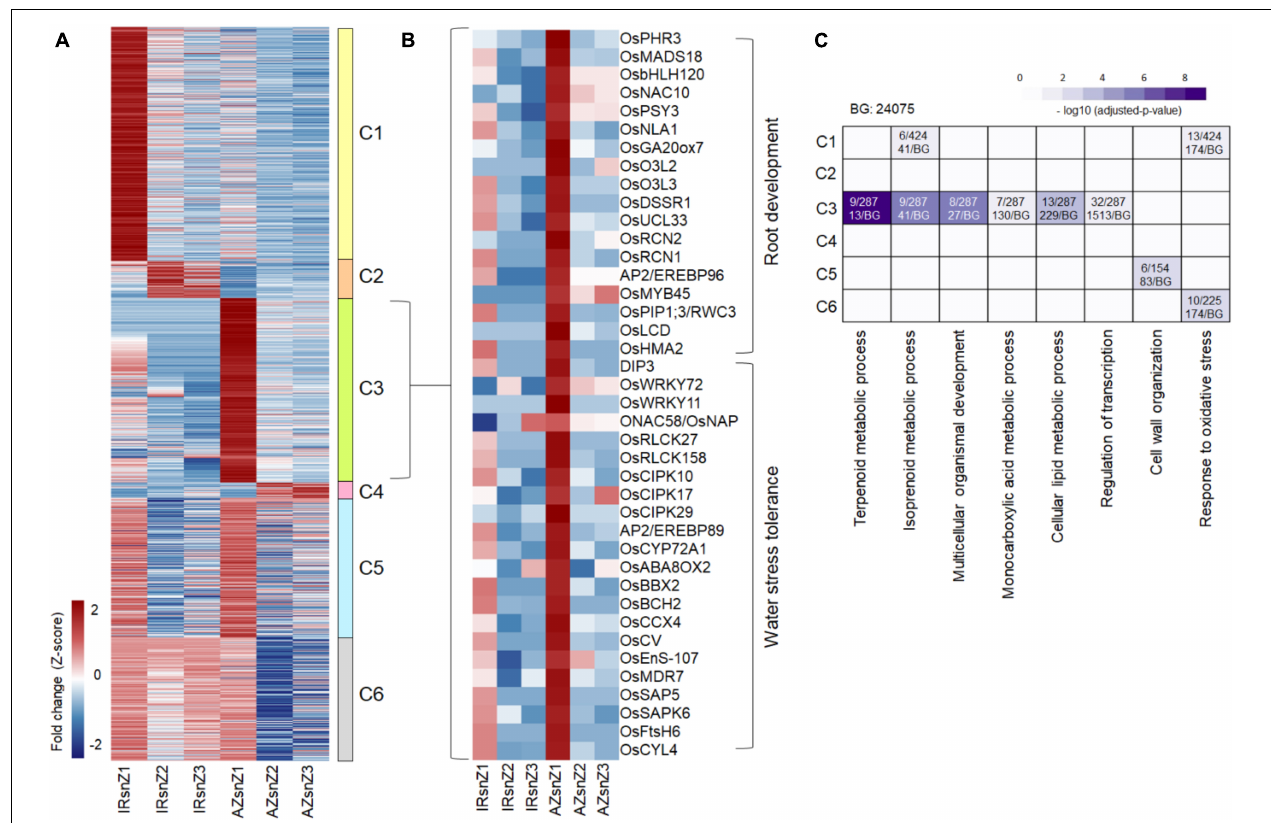
FIGURE 5 | Differentially expressed genes with a high fold change between control and stress conditions in two contrasting genotypes of rice. (A) Heatmap representing the DEGs with high fold changes (more than fourfold) between control and stress in the six clusters with distinct expression patterns across the three root zones of two contrasting genotypes of rice. The color bar depicts the gradient of fold changes in response to water stress. (B) Heatmap representing a subset of 40 genes extracted from cluster 3 with roles in root development and water stress tolerance. (C) BPs enriched in clusters 1–6 (C1–C6). The color bar depicts the gradient of –log10 (adjusted P -value) where P -value is the significance of individual GO-BPs enriched with each cluster. The proportion of gene numbers included in each BP in annotated gene numbers of the cluster (on top) along with the proportion of total gene numbers included in each BP in annotated gene numbers of the background (at bottom) were mentioned in the boxes. IRsnZ1, expression changes in zone1 of IR64 (Stress vs. Control); IRsnZ2, expression changes in zone2 of IR64 (Stress vs. Control); IRsnZ3, expression changes in zone3 of IR64 (Stress vs. Control); AZsnZ1, expression changes in zone1 of Azucena (Stress vs. Control); AZsnZ2, expression changes in zone2 of Azucena (Stress vs. Control); AZsnZ3, expression changes in zone3 of Azucena (Stress vs. Control).